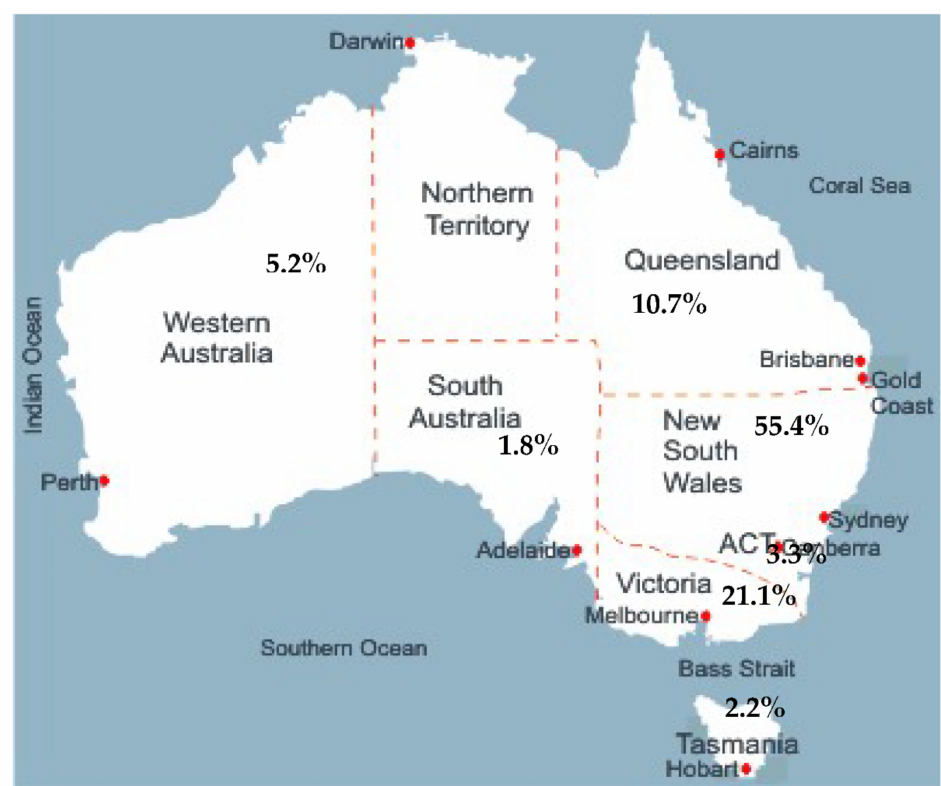
Figure 1. Geographic distribution of the participants’ states of residence in